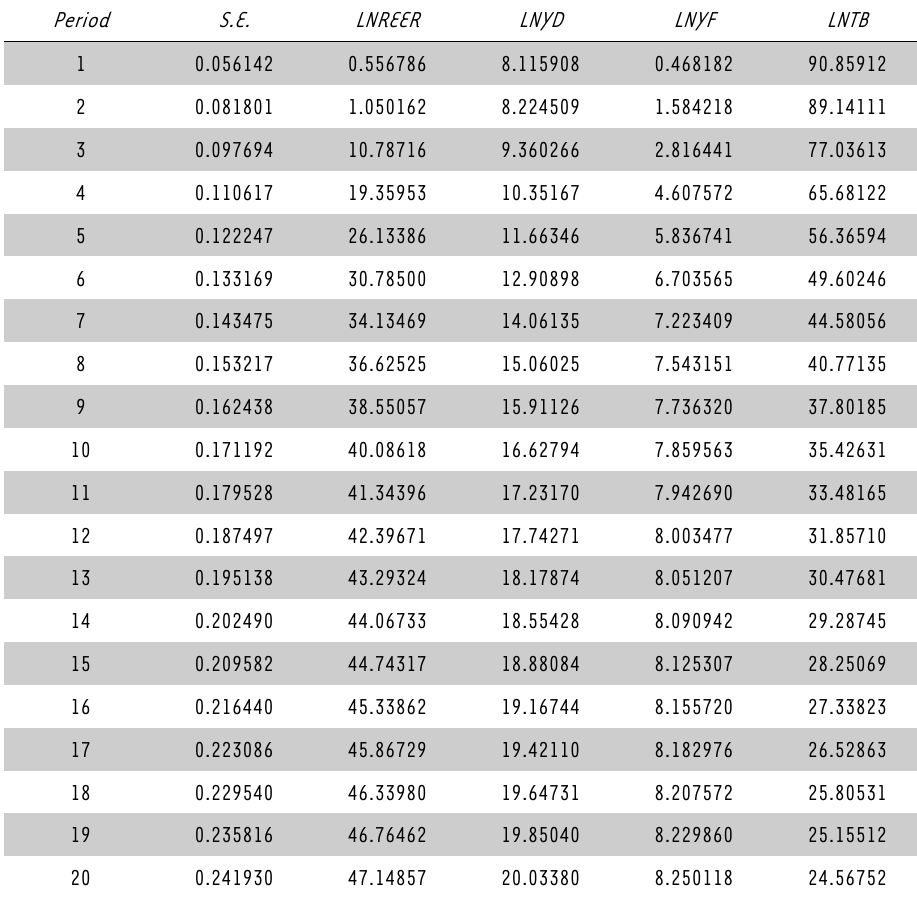
TABLE 4: Variance decomposition of the manufacturing trade balance Period